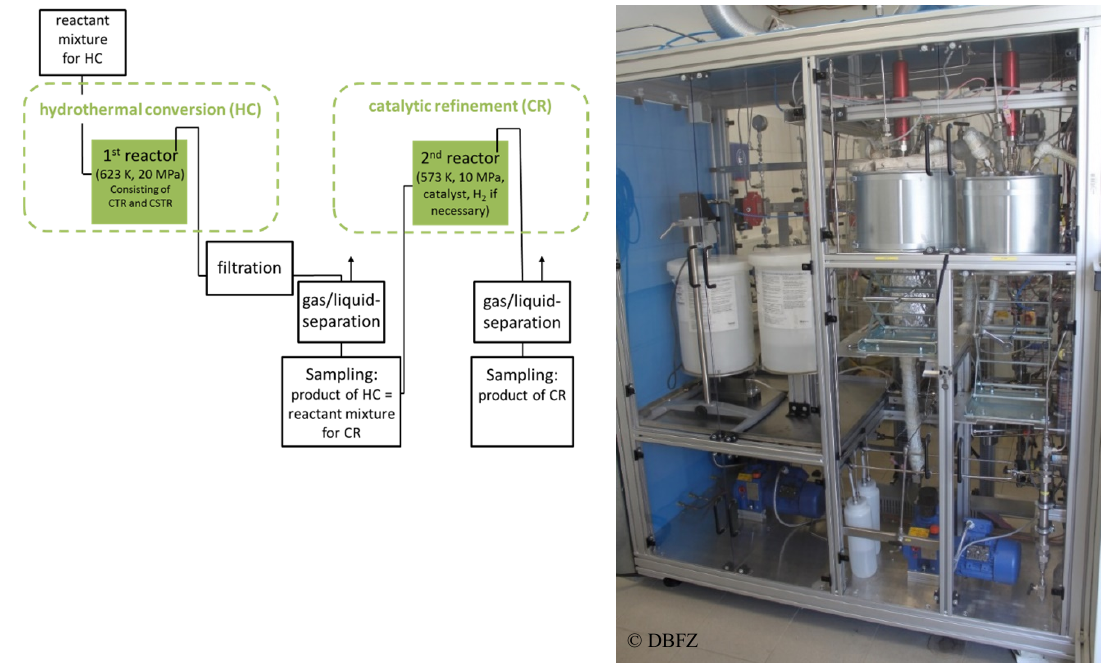
Figure 7. Schematic representation of the developed two stage reactor concept and picture of the two-stage hydrothermal laboratory plant.